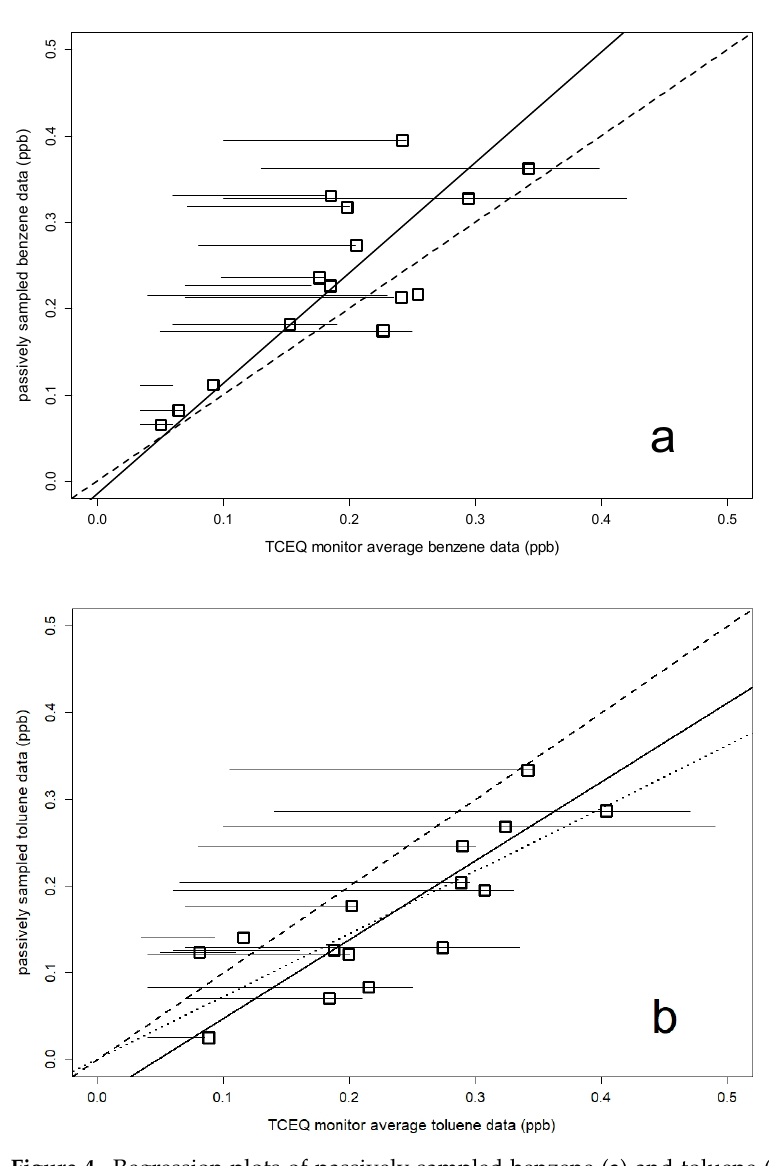
Table 1. Regression statistics for selected NMHCs comparing averaged hourly state monitor meas- urements to passively sampled data for 5–17-day deployment periods. OLS = ordinary least squares, RMA = ranged major axis, MNB = mean normalized bias [76] .